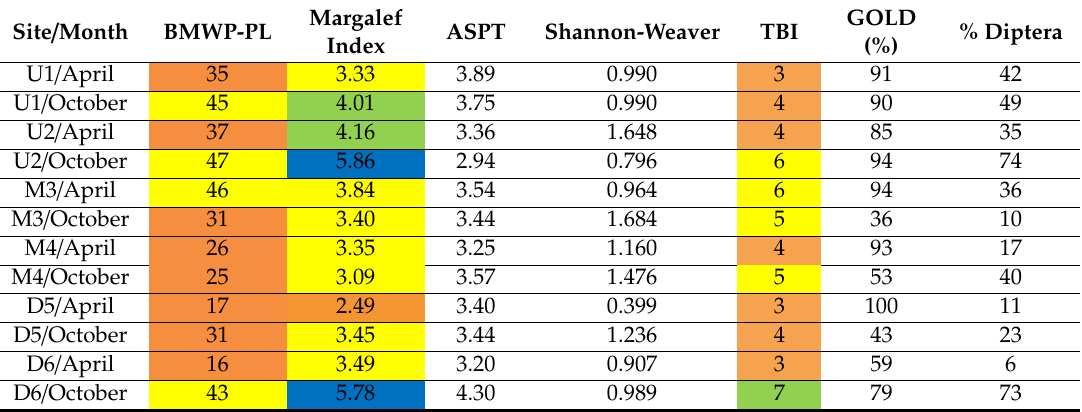
Table 4. The values of the calculated indexes and metrics at the examined sites. Orange color stands for poor quality of water (IV class), yellow for moderate water quality (III class), green for good quality of water (II class), and blue for very good quality of water (I